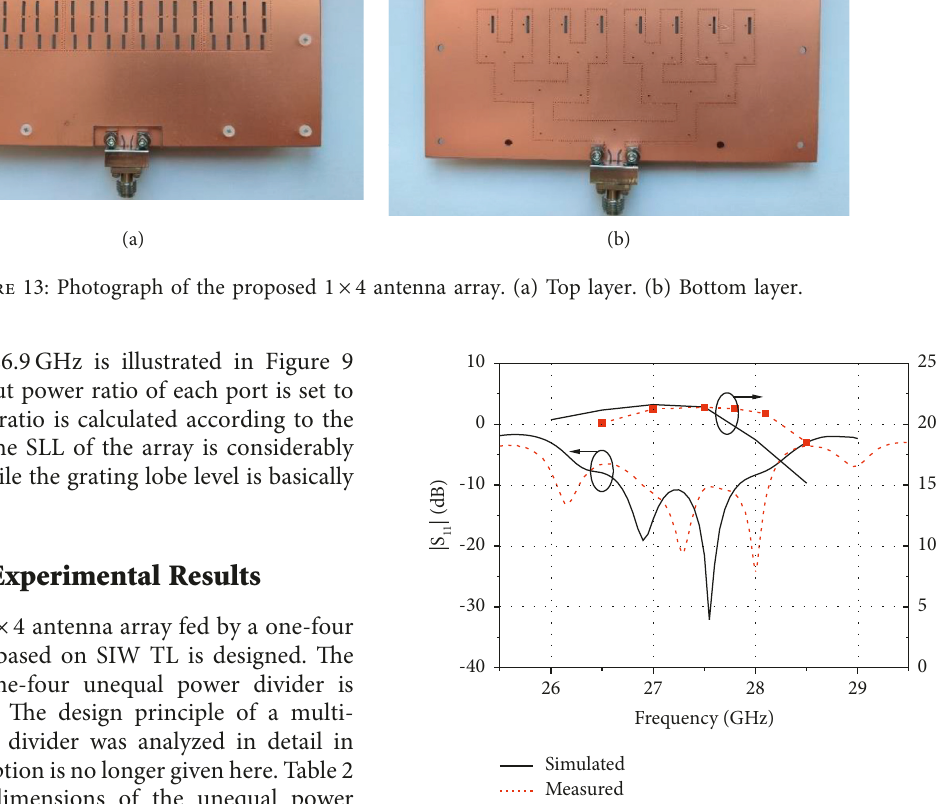
11 | and gains of the 1